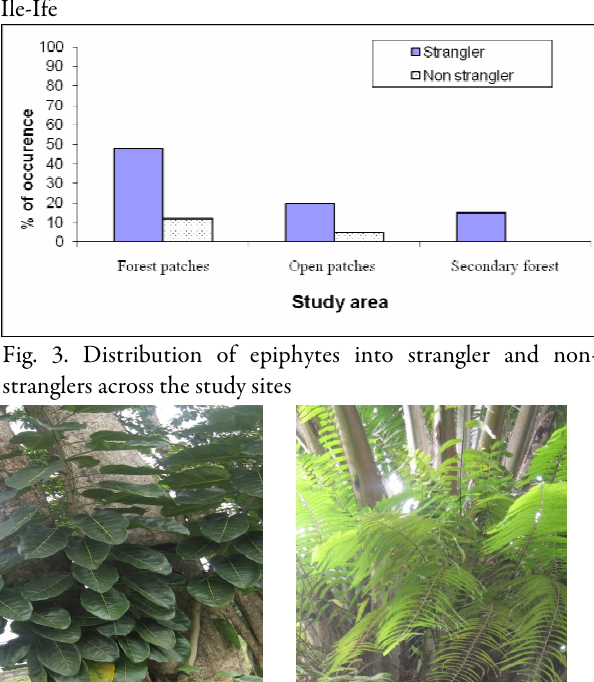
Fig. 5. Epiphytes distribution based on the bark characteristic across the study